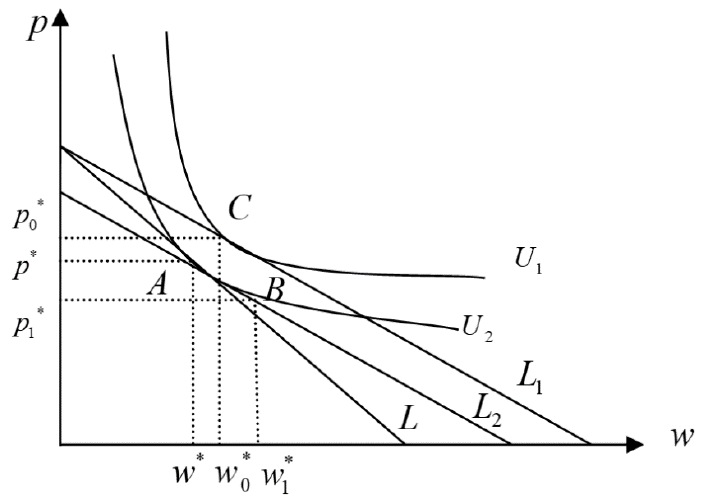
Figure 2. Schematic Diagram of the Reaction Mechanisms of Urban Population Agglomeration Affecting Haze Pollution. w denotes haze concentration, and p denotes urban population density. Line L is a combination of population density and haze concentration. Curve U represents environmental carrying capacity. Point A represents the equilibrium state attained with a haze concentration of w* and a population density of p* under the condition of urban environment carrying capacity U2.